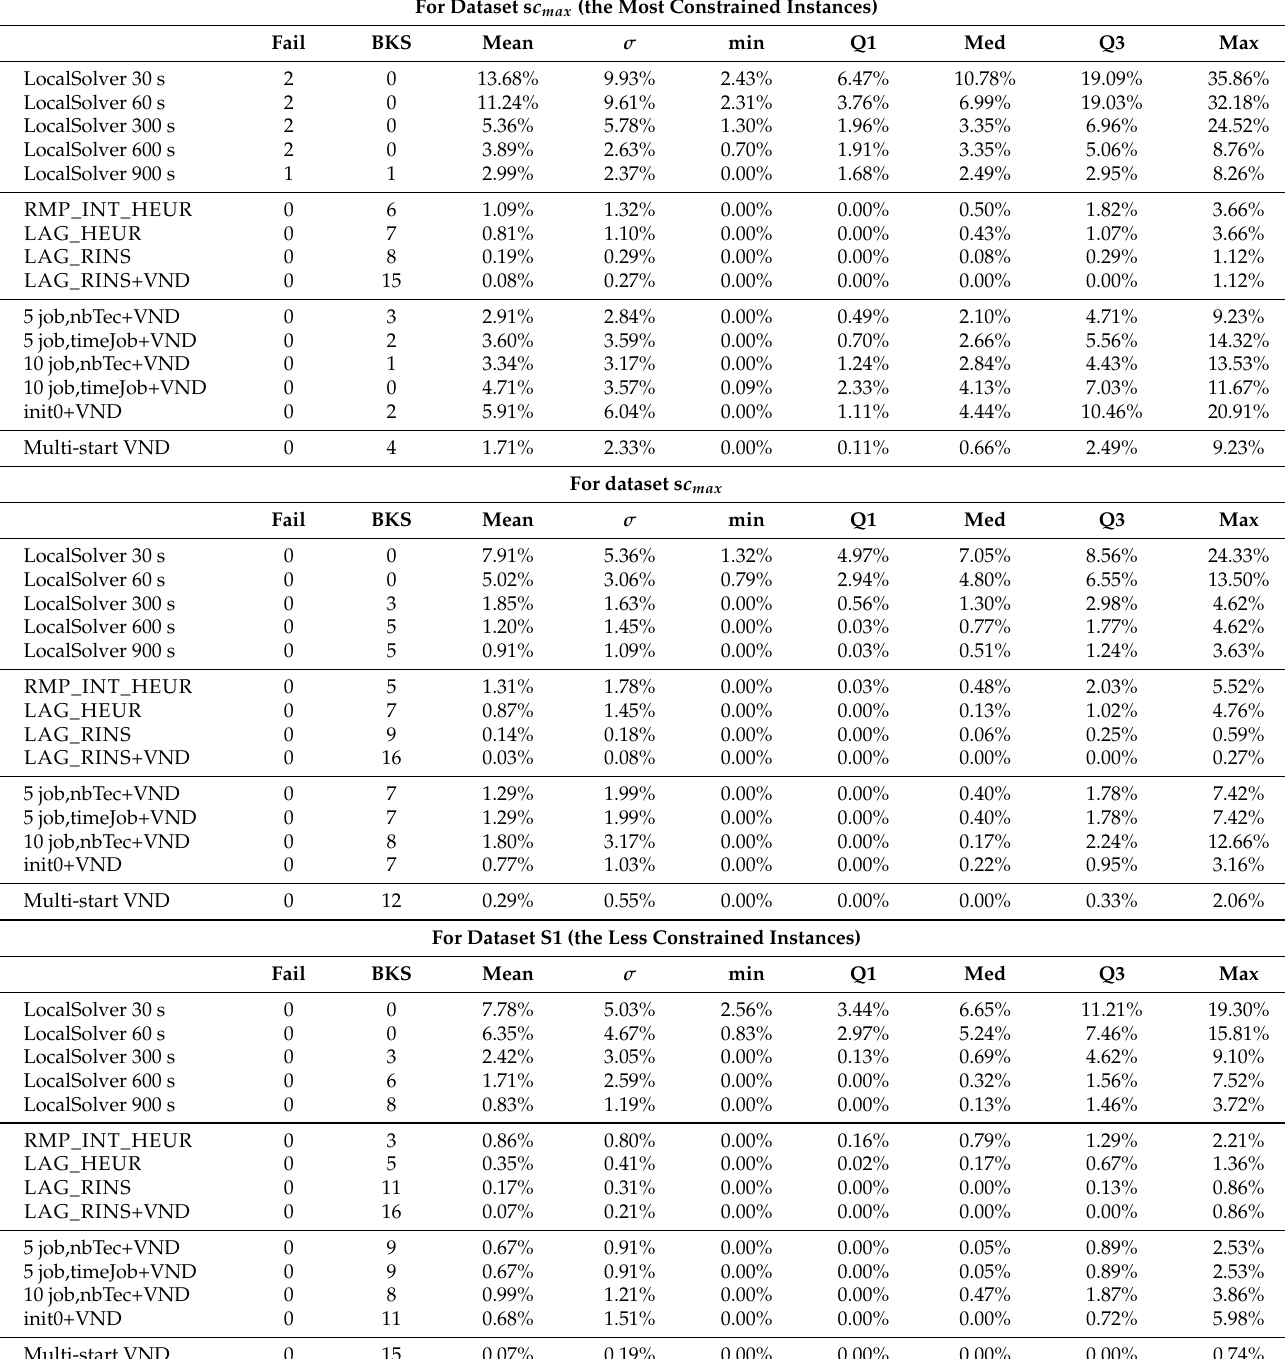
Table 6. Comparison of the solution quality of local search approaches for the 17 mid-size instances of dataset s c max , S c max and S1. LocalSolver results are reported for defined time limits, CG heuristics and VND matheuristics at termination. For VND matheuristics, different initialization are provided, and the multi-start VND considers the reported initialization for a parallel or multi-start